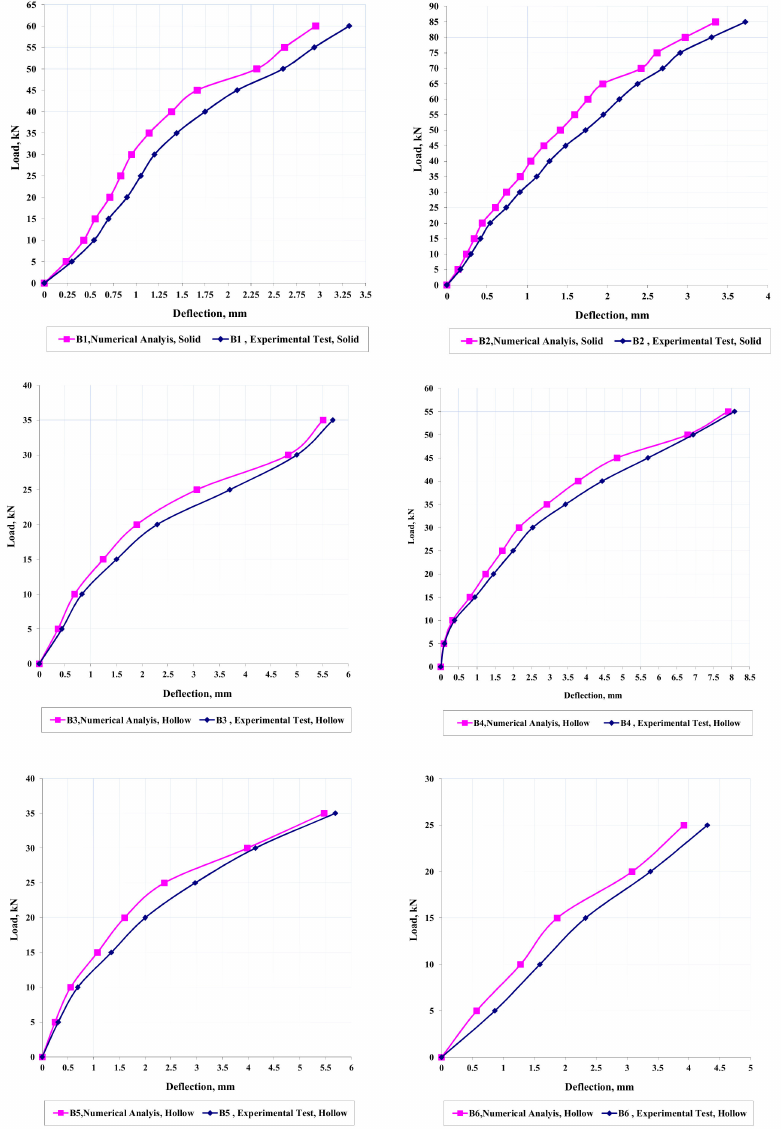
Figure 18. Comparisons of the numerical and experimental load-deflection curves for individual RC beam models up to the ultimate